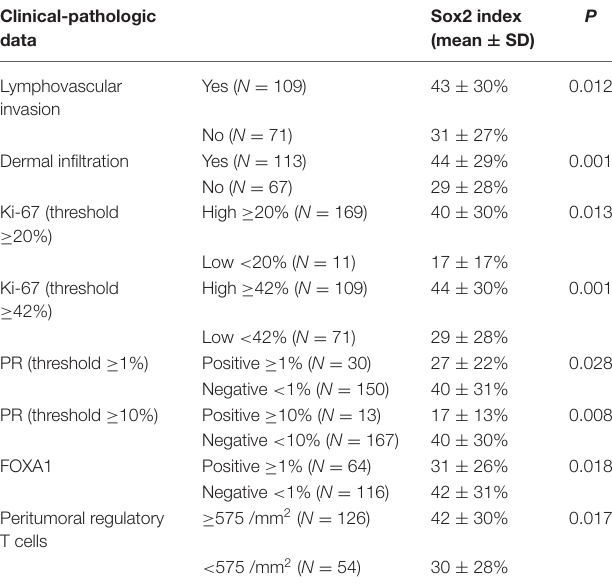
TABLE 2 | Clinical-pathologic associations with Sox2 expression expressed as an index in feline mammary carcinomas ( N = 180). Clinical-pathologic